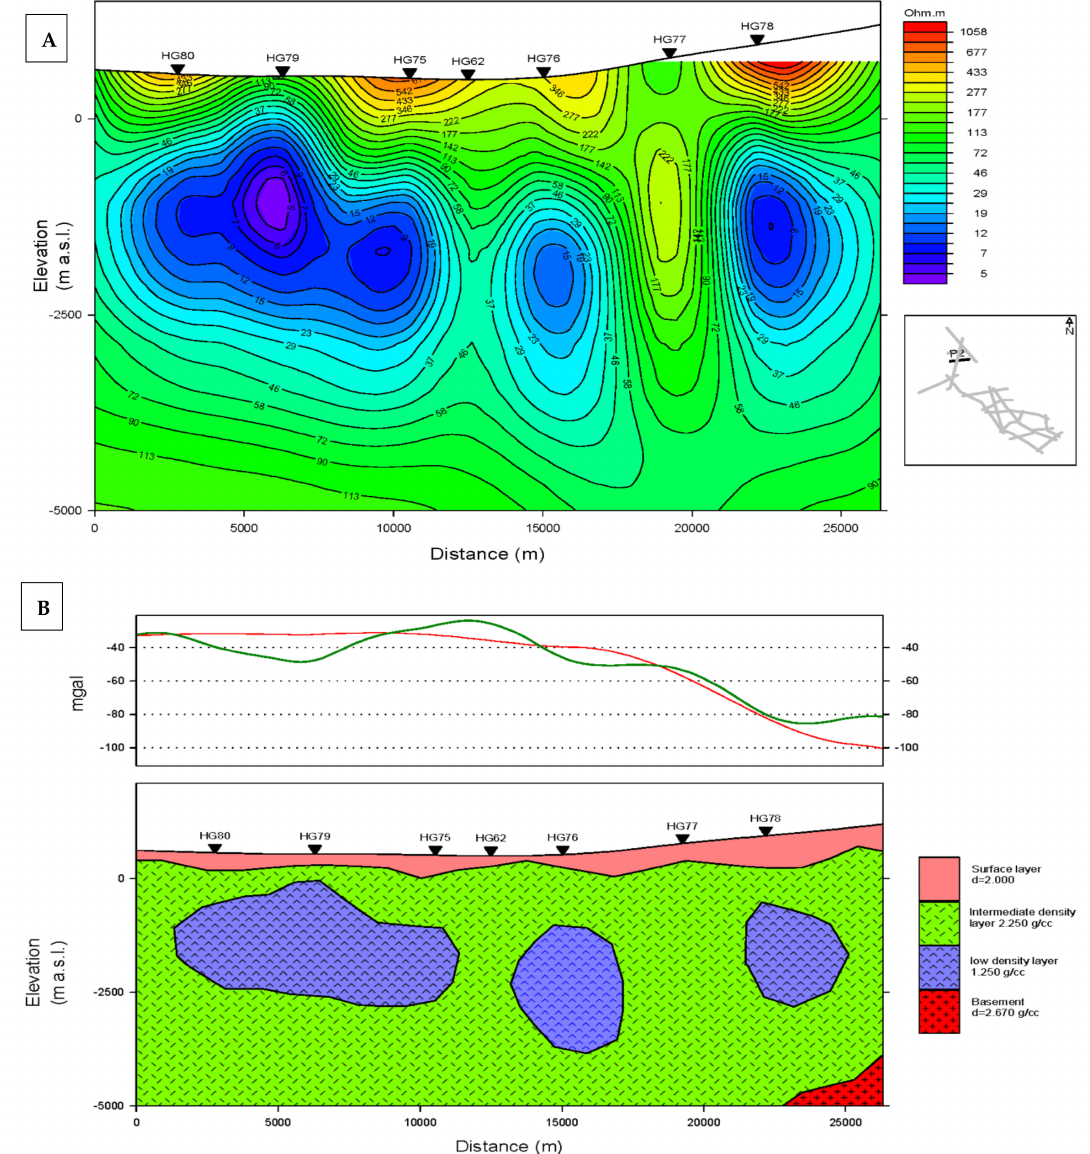
Figure 4. Profile-2 cross-section derived from ( A ) 2D modeling of AMT data (upper panel) and ( B ) density modelling (lower